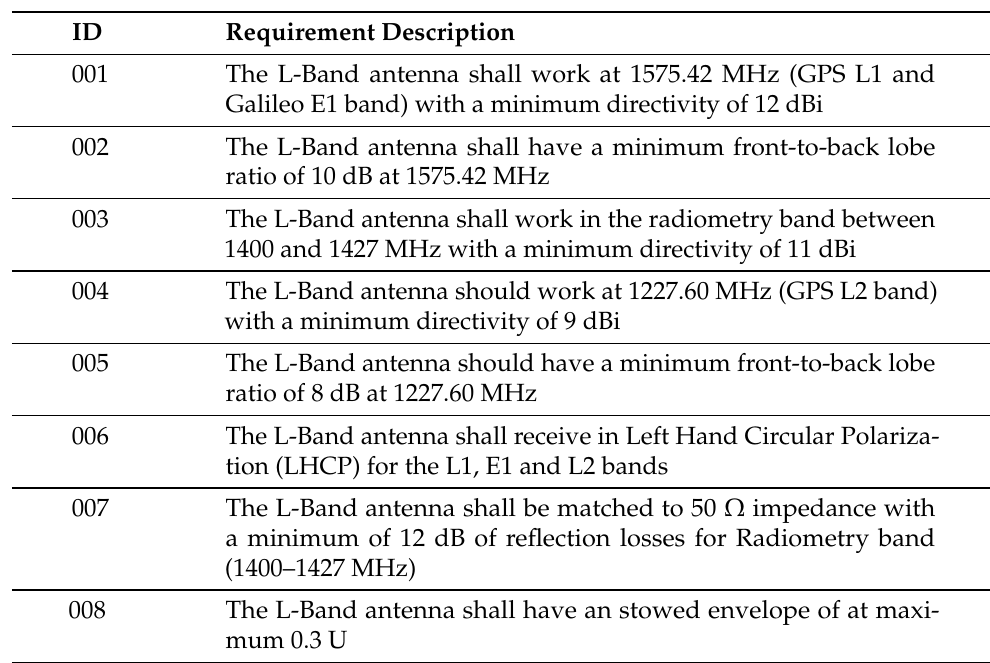
Table 1. Requirements for the